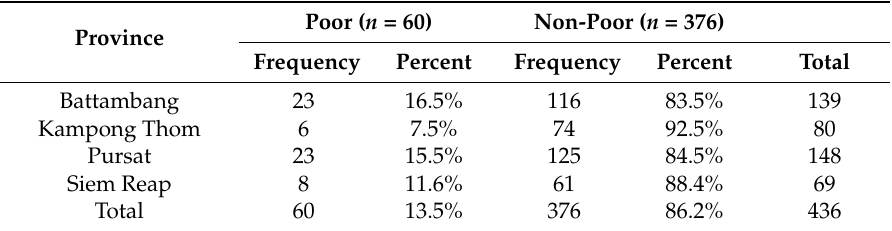
Table 1. Sample of aquaculture clients, by province and IDPoor (the Identification of Poor Households)